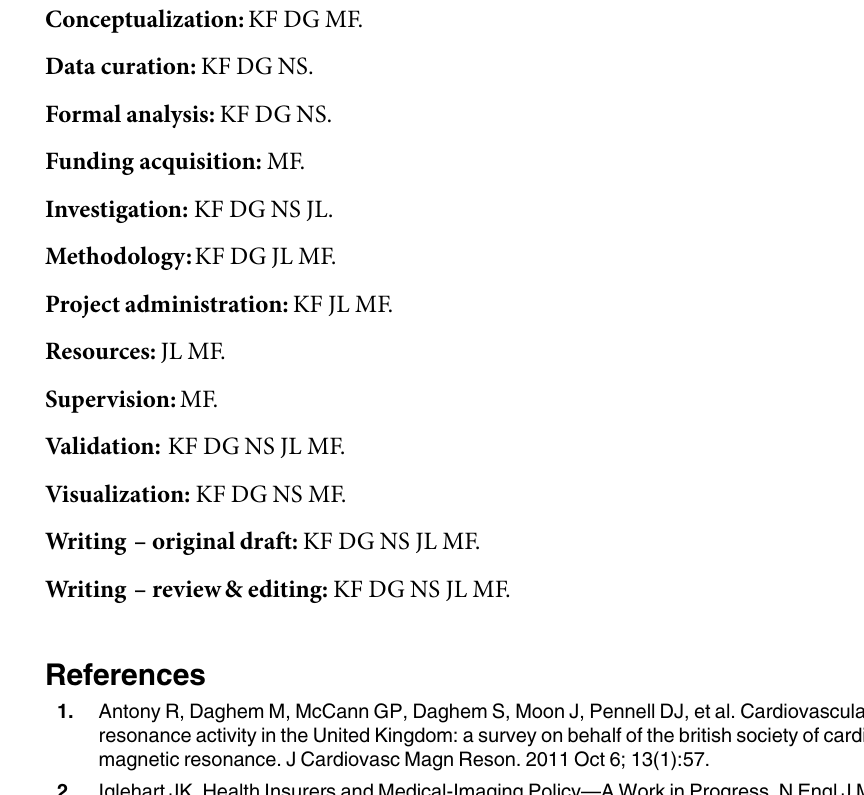
S1 Table. Invasive Measurements. Mean±SD change in values during the breathing maneu- vers ( (cid:3) denotes significance (p < 0.05) from baseline value). † O er baseline values were system- 2 atically higher in the stenosis animals as compared to control animals as shown in Table 1. Arterial partial pressure of carbon dioxide (paCO ); coronary sinus partial pressure of carbon 2 dioxide (pcsCO ); arterial partial pressure of oxygen (paO ); coronary sinus partial pressure of 2 2 oxygen (pcsO ); arterial saturation (SaO ); oxygen extraction ratio (O er); heart rate (HR); and 2 2 2 rate pressure product